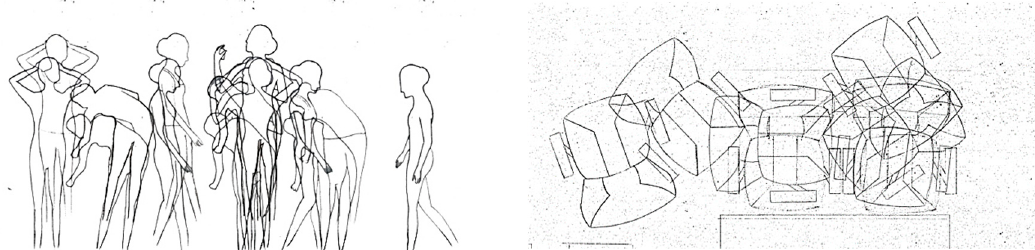
Figure 12. Verb activity analysis brainstorming the different possible ways of reading/studying. Work sample from Project Part II. Courtesy of Alaa Al Hashemi.